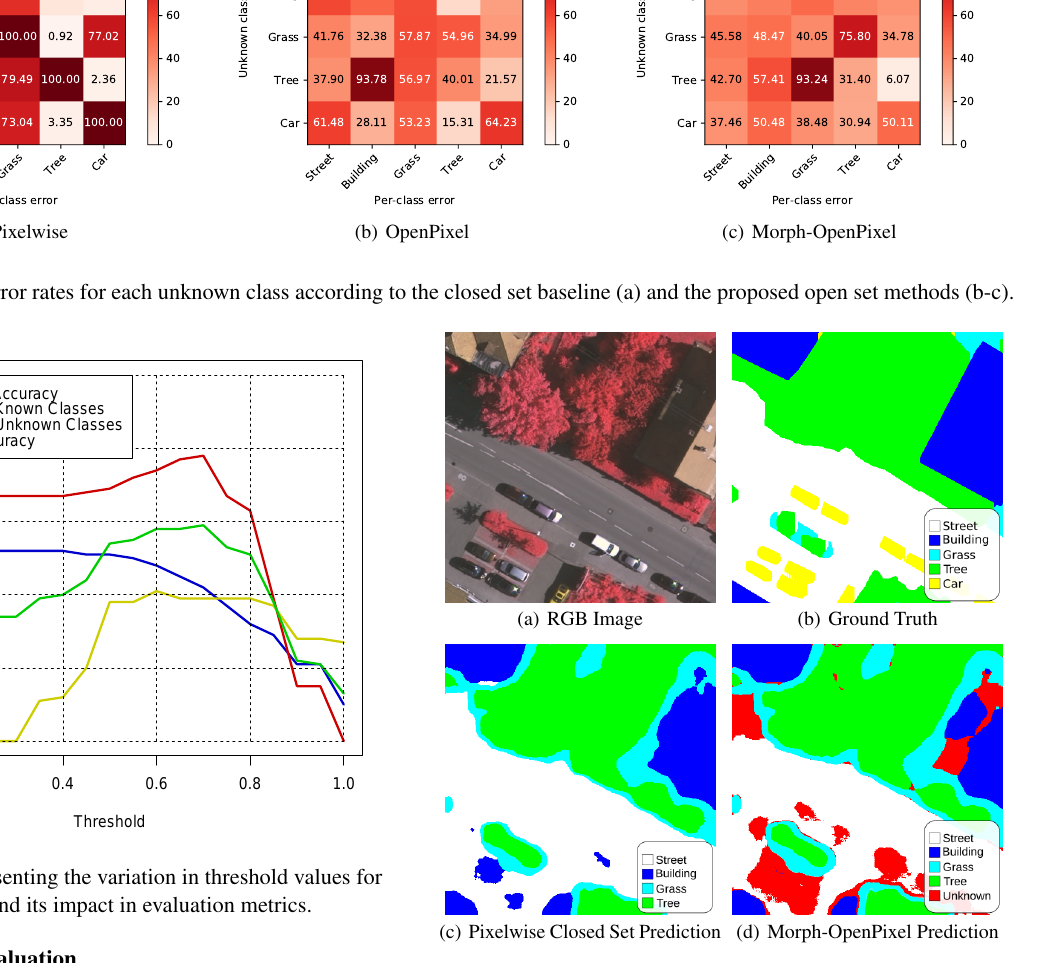
Figure 6. Example wherein Pixelwise wrongly classifies the unknown class (car) as known, while the Morph-OpenPixel classifies the areas as